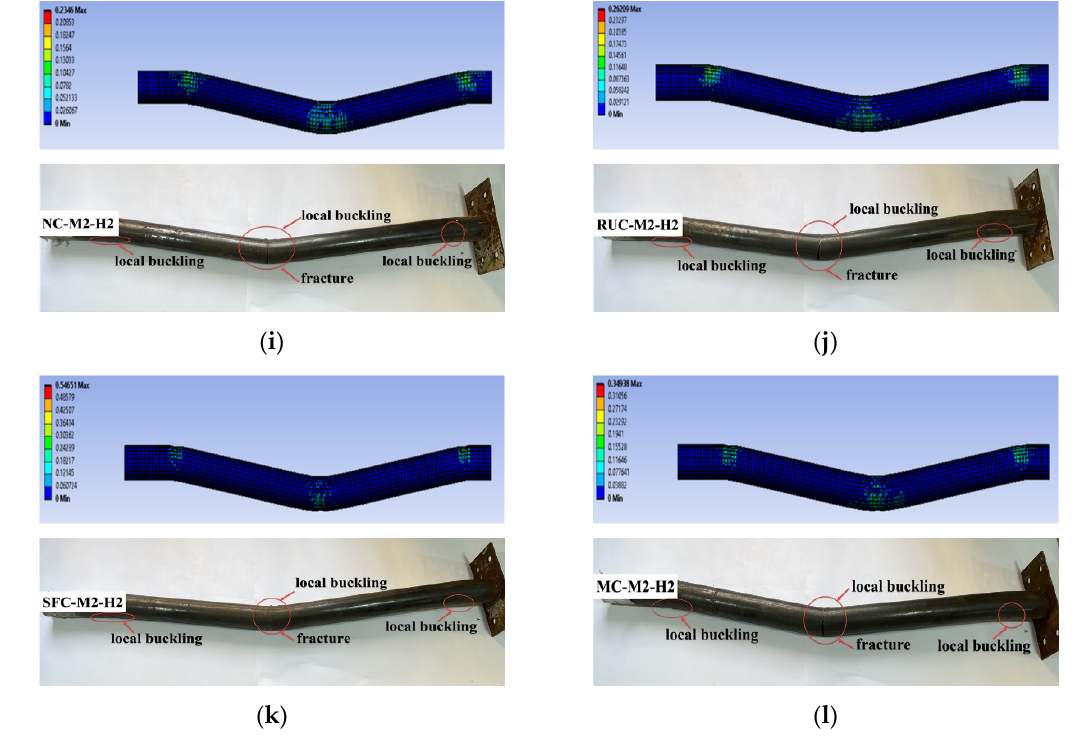
Figure 12. Failure modes of representative specimens: ( a ) NC-M1-H1; ( b ) RuC-M1-H1; ( c ) SFC-M1- H1; ( d ) MC-M1-H1; ( e ) NC-M1-H2; ( f ) RuC-M1-H2; ( g ) SFC-M1-H2; ( h ) MC-M1-H2; ( i ) NC-M2-H2; ( j ) RuC-M2-H2; ( k ) SFC-M2-H2; ( l )